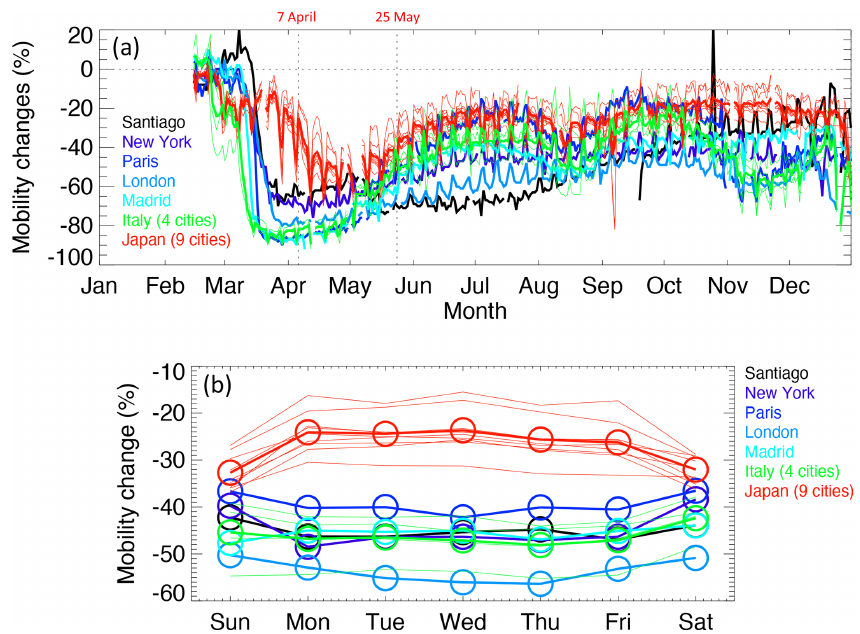
Figure 1. Google mobility data for the place category of transit stations in 2020 (from 15 February to 31 December) compared to the pre-COVID period for selected large metropolitan areas around the world strongly affected by the pandemic. For Japan and Italy, values were averaged (thick line) over nine (Tokyo, Kanagawa, Saitama, Chiba, Kyoto, Nara, Osaka, Fukuoka, Nagasaki) and four (Milan, Rome, Naples, and Turin) cities or prefectures (thin lines), respectively: (a) time series; (b) weekly changes. Holidays were removed. The baseline in both (a) and (b) is the median value for the corresponding day of the week during the 5-week period of 3 January–6 February 2020.